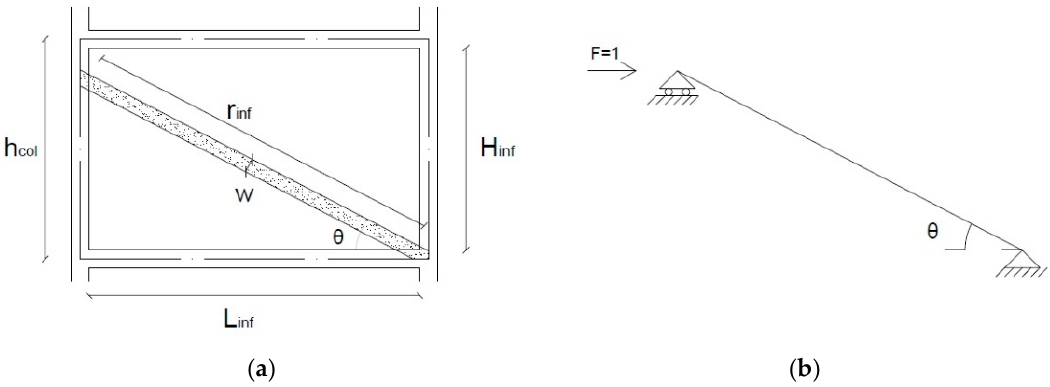
Figure 1. Infill wall: ( a ) schematization and ( b ) static scheme to determine the equivalent stiffness of the infill walls.